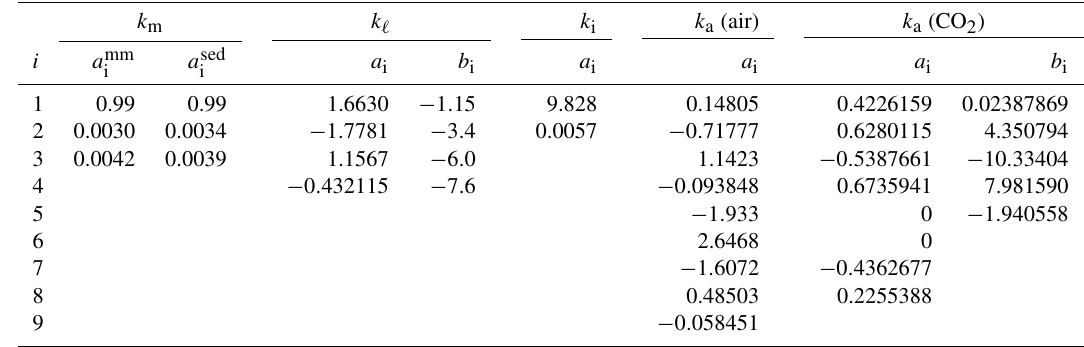
Table 2. Coefficients a i and b i in Eqs. (18), (21)–(22), (24), and (26)–(27) for the thermal conductivity of matrix minerals, liquid water, ice, air, and CO 2 gas ( k x in Wm − 1 K − 1 ). For matrix minerals, a mm sedimentary mineral assemblages, respectively.